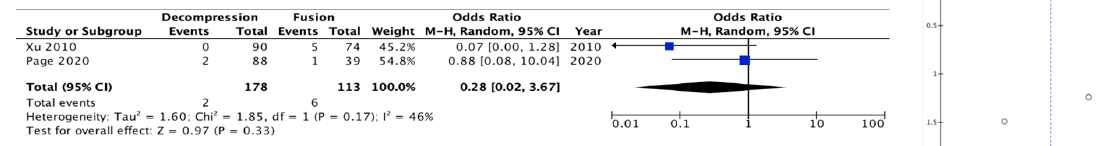
Figure A6. Bowel/bladder de fi cits.